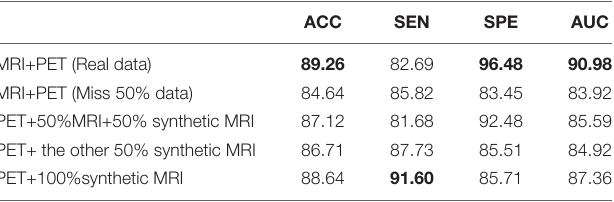
TABLE 7 | In this AD vs. CN classification experiment, all PET images are real, but MR images were divided into five cases. ACC SEN